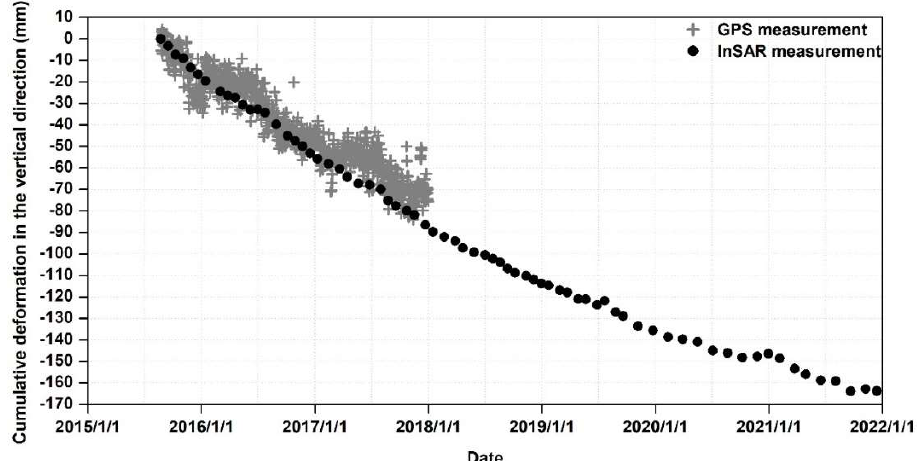
Figure 9. Cumulative time series deformation obtained from InSAR-derived and GPS observations.